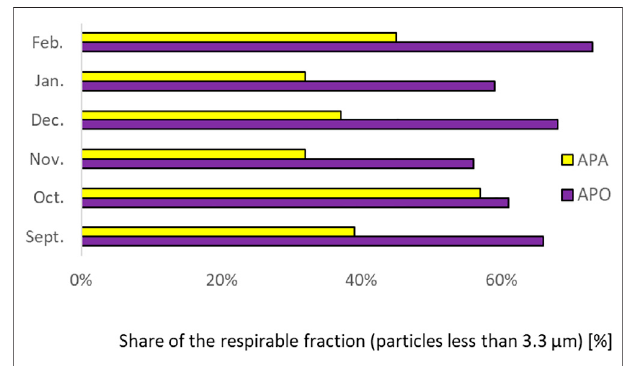
FIGURE 3 | The share of the respirable fraction of bacterial aerosols when APO/when APA.